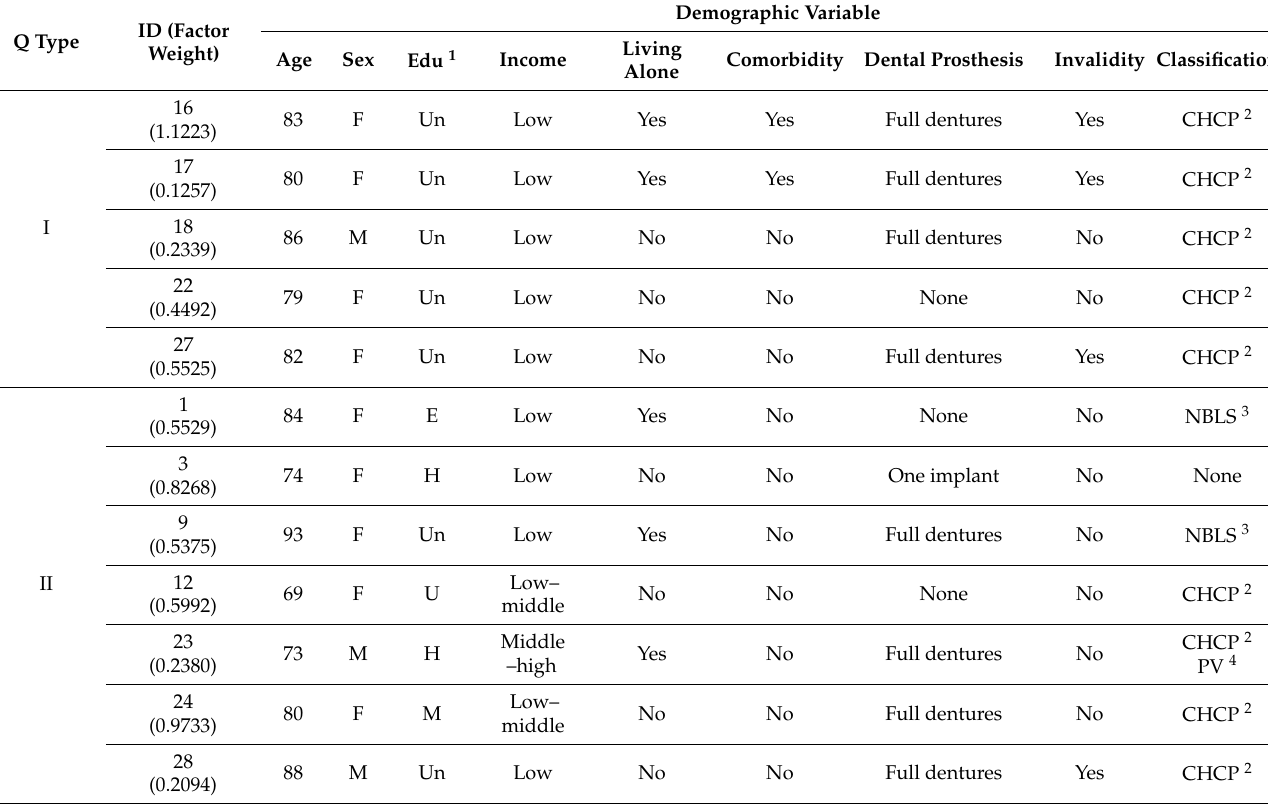
Table 2. General characteristics and factor weights of P-samples by